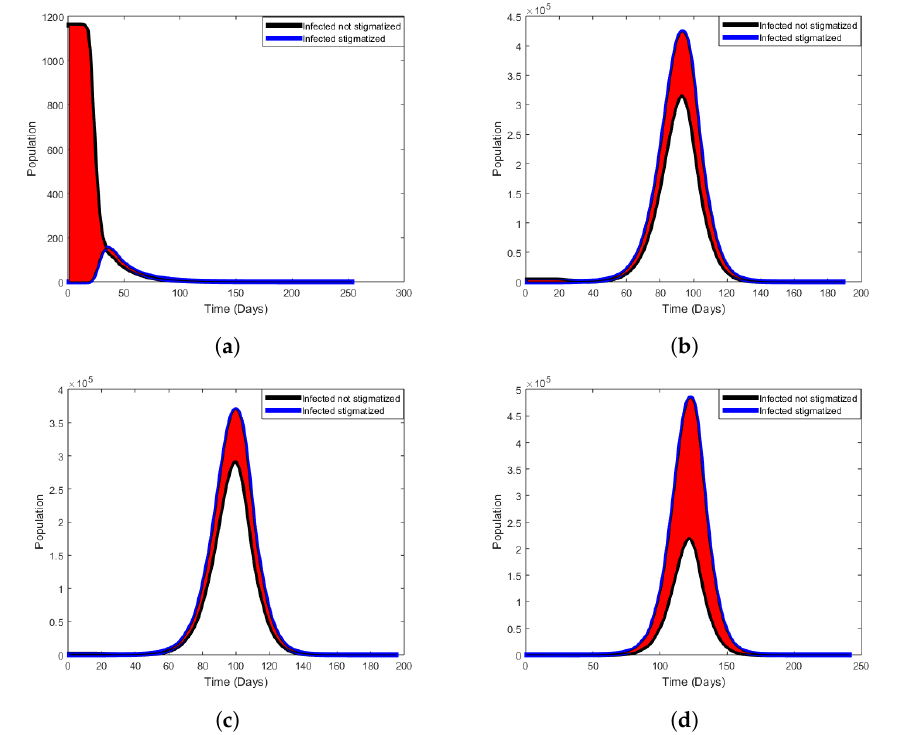
Figure 12. Low regime state. ( a ) Wave 1. ( b ) Wave 2. ( c ) Wave 3. ( d ) Wave